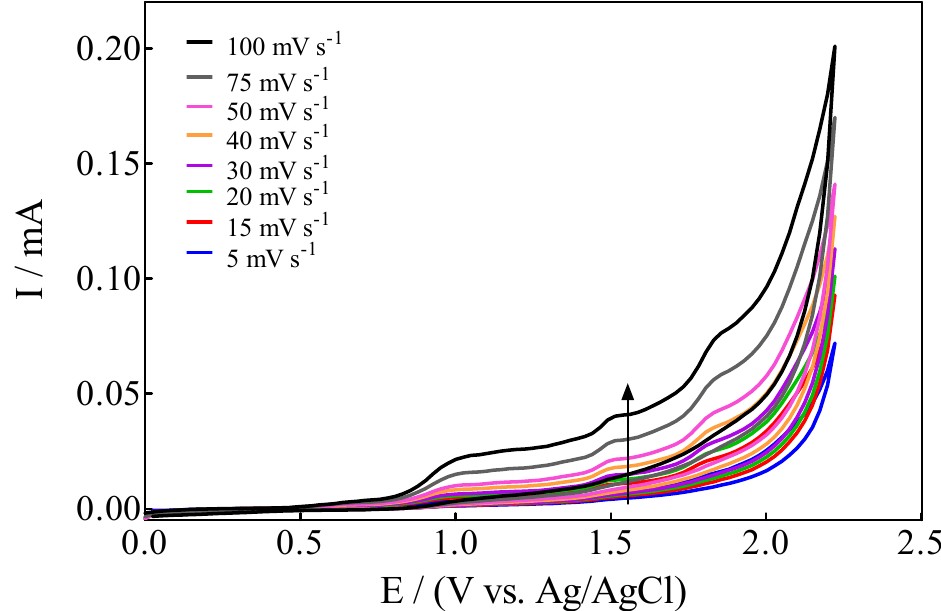
Figure 3. Cyclic voltammograms of Calcon (100 mg L − 1 ) on BDD in 0.25 M H 2 SO 4 as a function of the scan rate from 5 to 100 mV s − 1 .